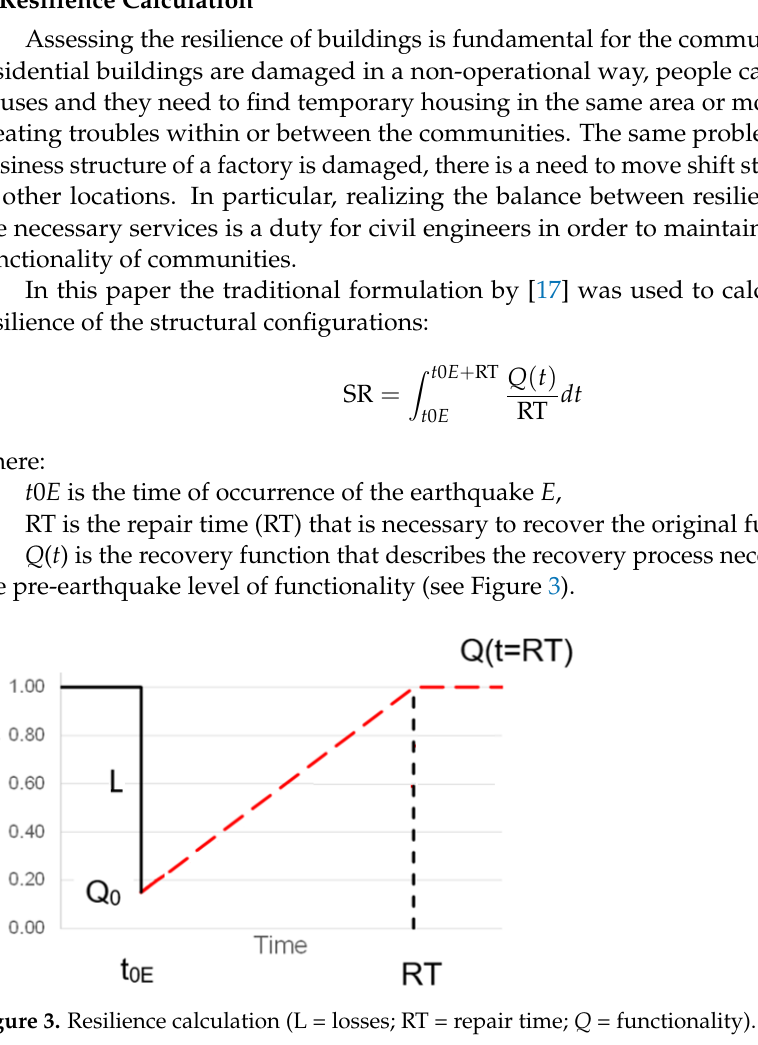
Figure 3. Resilience calculation (L = losses; RT = repair time; Q = functionality).